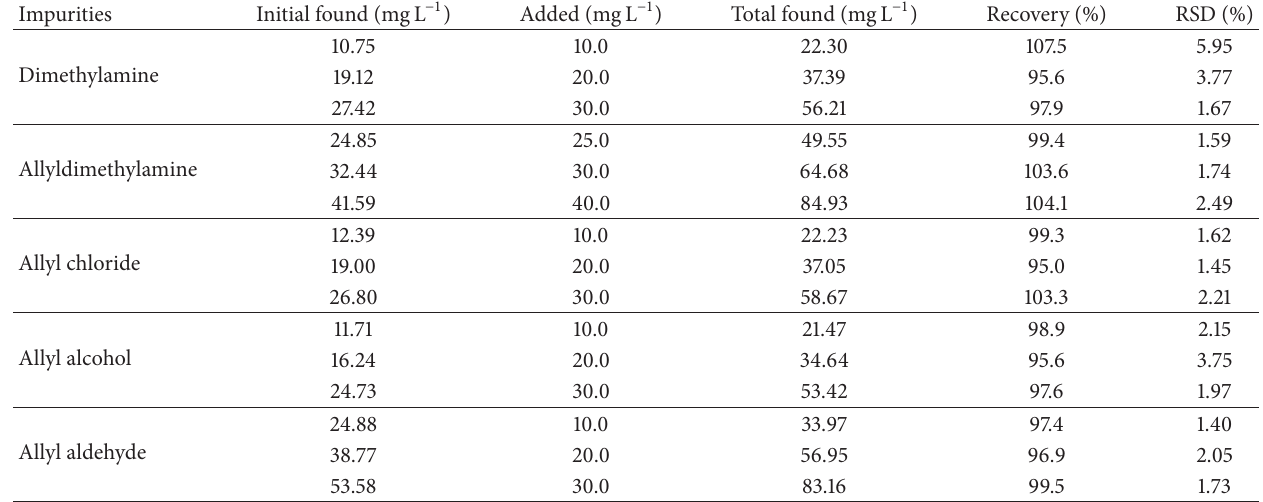
Table 3: Precision and recovery for allyl chloride and its derivatives ( 𝑛 = 6 ).